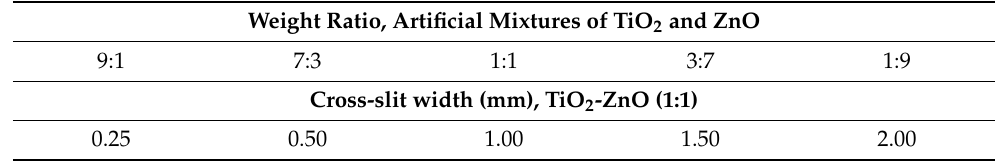
Figure 1. Schematic of diffraction experiment: in reflection mode, the incident radiation can be modified by changing the width of the divergence cross-slit ( a ). Divergent cross-slit: composed of two vertical variable slits, the slit width can be adjusted to change the passing area of incident radiation ( b ). Table 1. TiO 2 -ZnO weight ratio and divergent cross-slit width of XRD